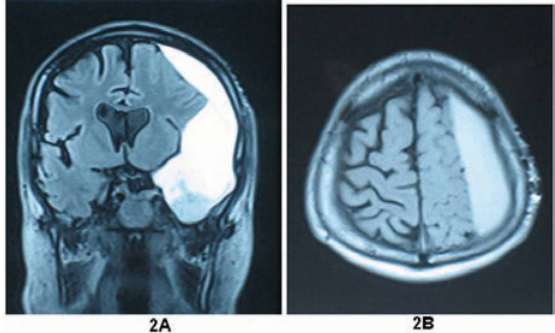
Figure 2. T1 weigthed coranal (A) and axial (B) MRI demonstrating hemorrhagic arachnoid cyst and subdural effusion on the left side.